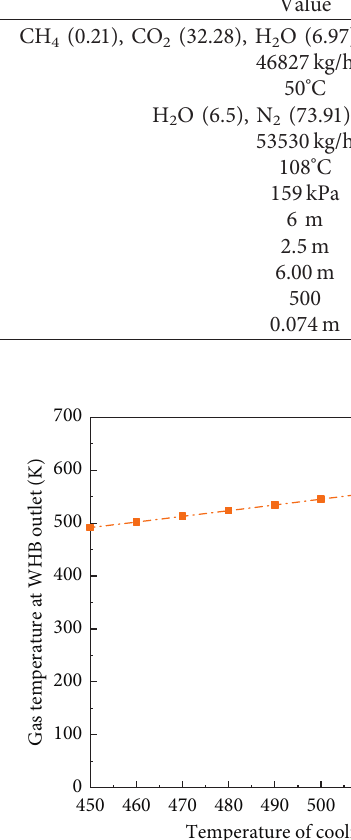
Table 4: The structure parameters and inlet operating condition in the Puguang gas field. Parameters